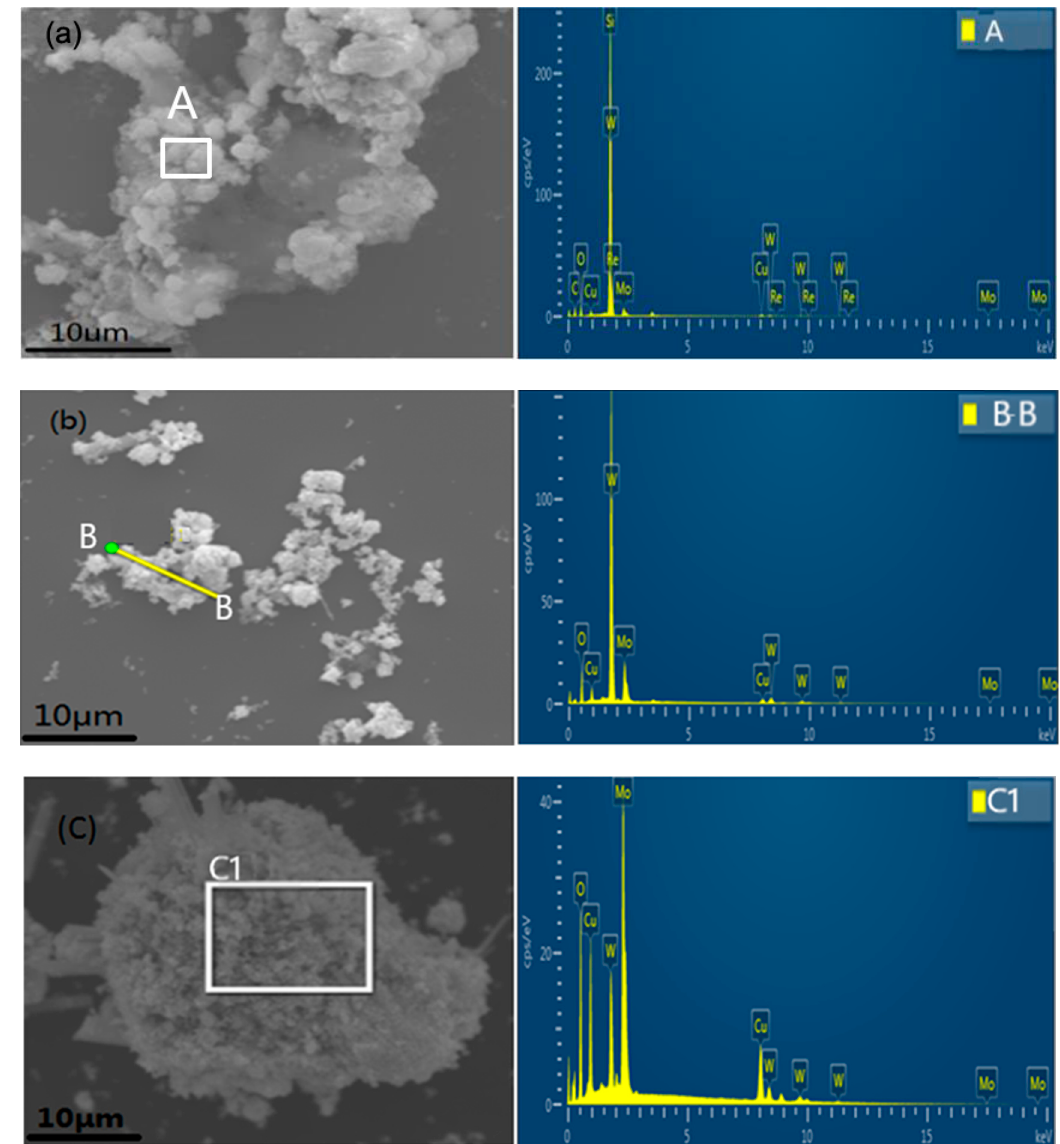
Table 1. Molar ratio of Cu:Mo:W.